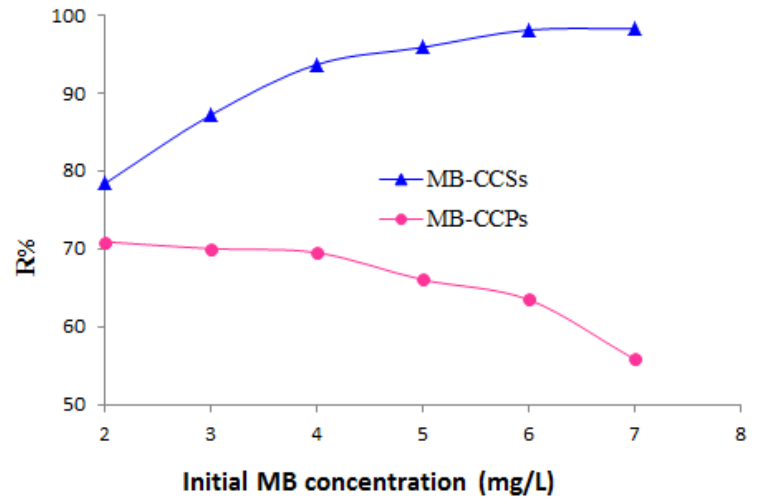
Figure 5. Effect of initial MB dye concentration on the removal efficiency of MB dye using CCSs and CCPs.